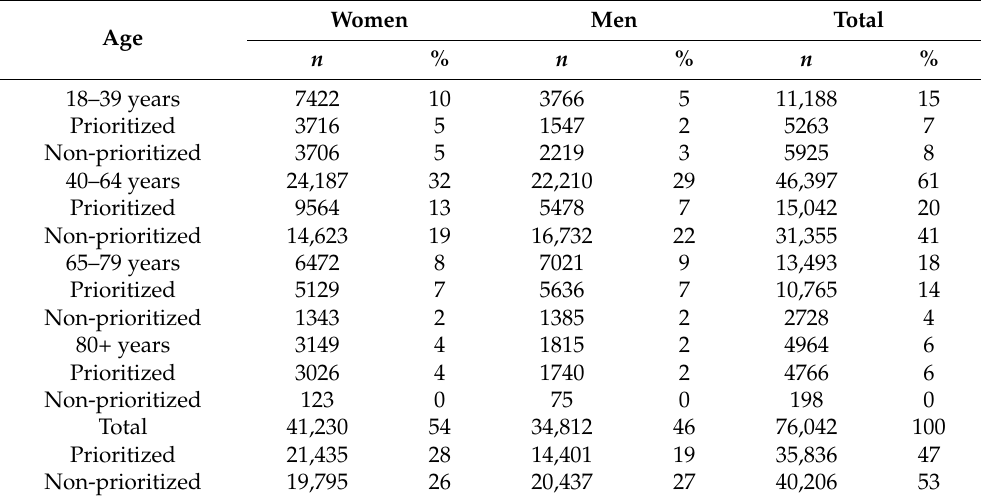
Table 1. Age and sex in the case-control population vaccinated with the BNT162b2 vaccine by 31 July 2021 in Östergötland, Jönköping, and Skåne counties, Sweden ( n = 76,042) displayed by vac- cination phase (prioritized first phase and non-prioritized second phase).